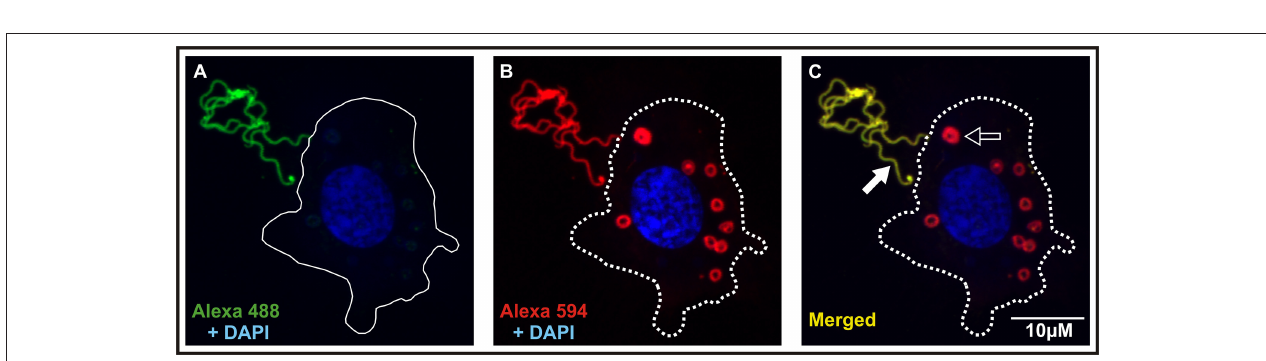
FIGURE 6 | Dual staining is necessary for proper interpretation of the Borrelia phagocytic assay. Hemocytes of adult semi-engorged females were mixed in vitro with B. afzelii CB43. The slides were then incubated with anti- Borrelia primary antibody and stained with Alexa 488 (A) . Finally, cell membranes of hemocytes were permeabilized, incubated again with the anti- Borrelia primary antibody, and stained with Alexa 594 and DAPI (B) . Borrelia spirochetes localized outside or on the surface of hemocytes are stained green and red, engulfed spirochetes are stained only red. The 488/594 (FITC/Texas red) dual filter can be used for rapid analysis of the slides (C) and can distinguish between phagocytosed (red; black arrow) and non-phagocytosed spirochetes (yellow; white arrow). Full and dashed lines indicate the hemocyte surface before and after permeabilization, respectively.